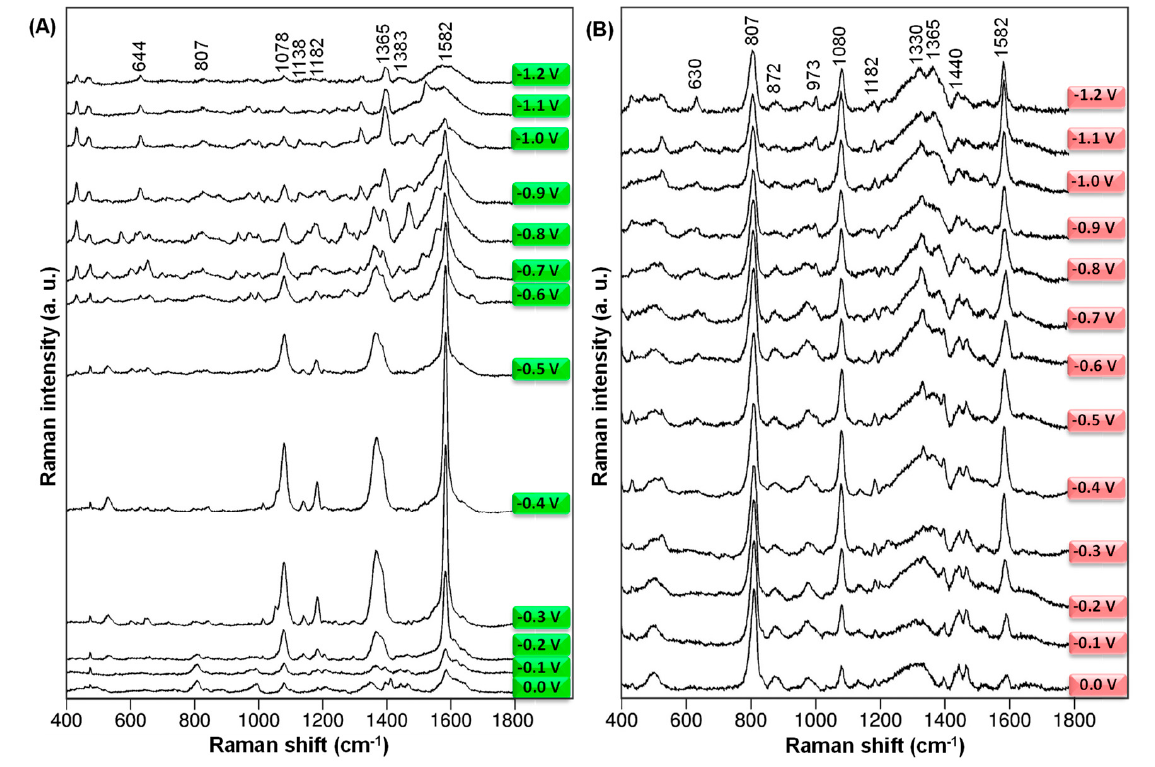
Figure 2. The potential-dependent SERS spectra of BB-94 adsorbed onto an electrochemically roughened Ag electrode at 0.0 V, − 0.1 V, − 0.2 V, − 0.3 V, − 0.4 V, − 0.5 V, − 0.6 V, − 0.7 V, − 0.8 V, − 0.9 V, − 1.0 V, − 1.1 V, and − 1.2 V electrode potential values were registered at 532 nm ( A ) and 785 nm ( B ) excitation lines.